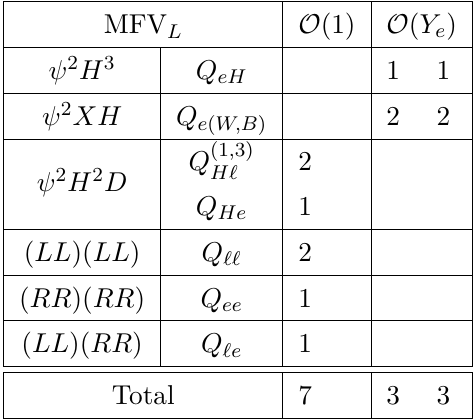
Table 13 . Counting of the pure lepton SMEFT operators (see appendix A) assuming MFV L symmetry in the lepton sector. The counting is performed up to one insertion of Y e spurion. The left (right) entry in each column gives the number of CP even (odd) coefficients at the given order in spurion